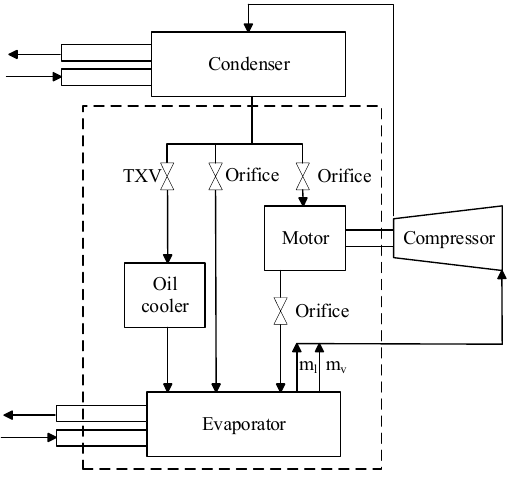
Figure 2. Refrigerant flow chart of a single-stage centrifugal chiller.